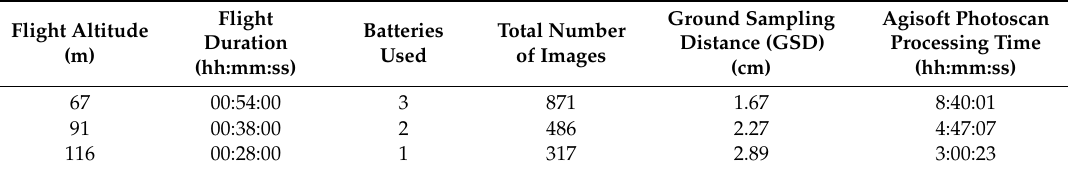
Table 2. UAS Survey Flight Altitude